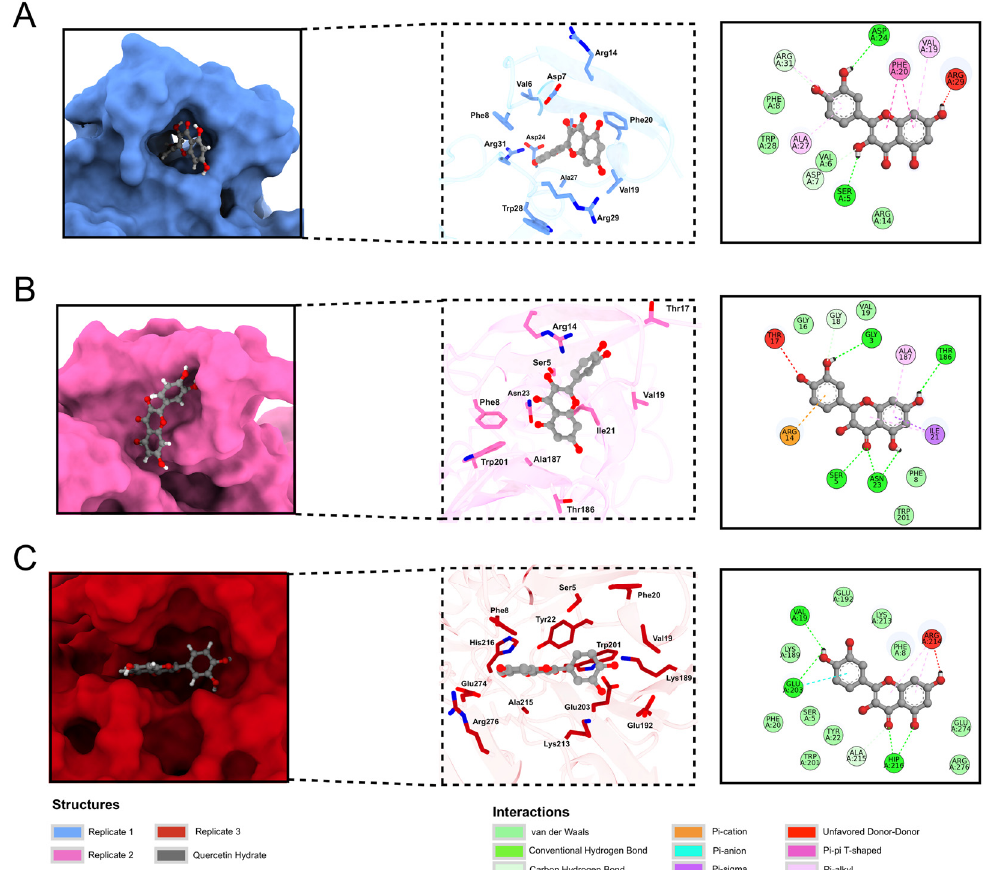
Figure 6. Best docking poses of quercetin hydrate in NS1 protein replicates. The ADV score for replicate 1 ( A ) was − 6.985 kcal/mol, for replicate 3 ( B ) was − 6.899 kcal/mol, and for replicate 5 ( C ) was − 8.347 kcal/mol. The protein is represented as a surface (left panel) and stick structure (middle panel), and quercetin hydrate is represented as a gray ball and stick structure. Oxygen and nitrogen atoms are shown in blue and red, respectively.